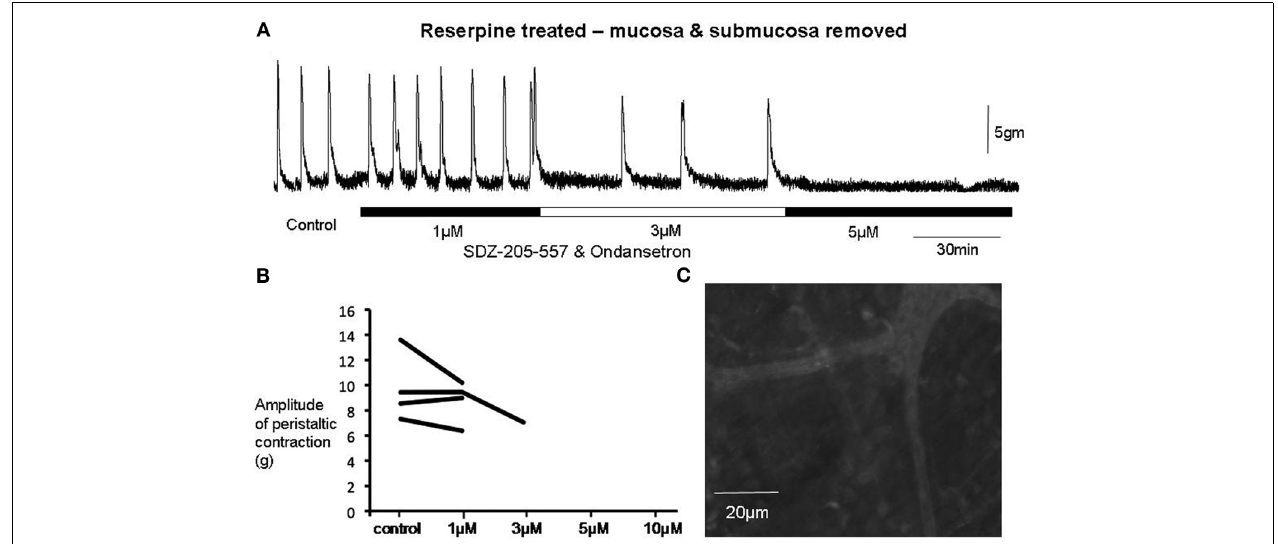
FIGURE 7 | (A) In a reserpine-treated animal, with mucosa and submucosal plexus removed, the combined application of SDZ-205-557 and ondansetron had potent inhibitory effects on peristaltic contractions, even despite the lack of any 5-HT detected in these preparations with mass spectrometry or immunohistochemistry. The recording shows that